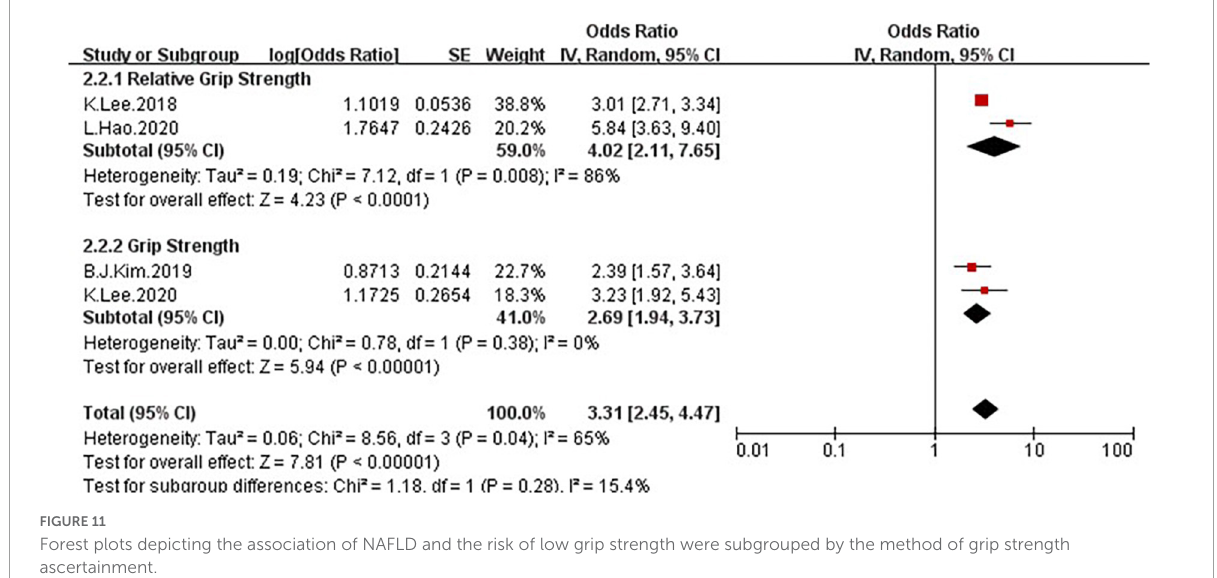
FIGURE11 Forest plots depicting the association of NAFLD and the risk of low grip strength were subgrouped by the method of grip strength ascertainment.